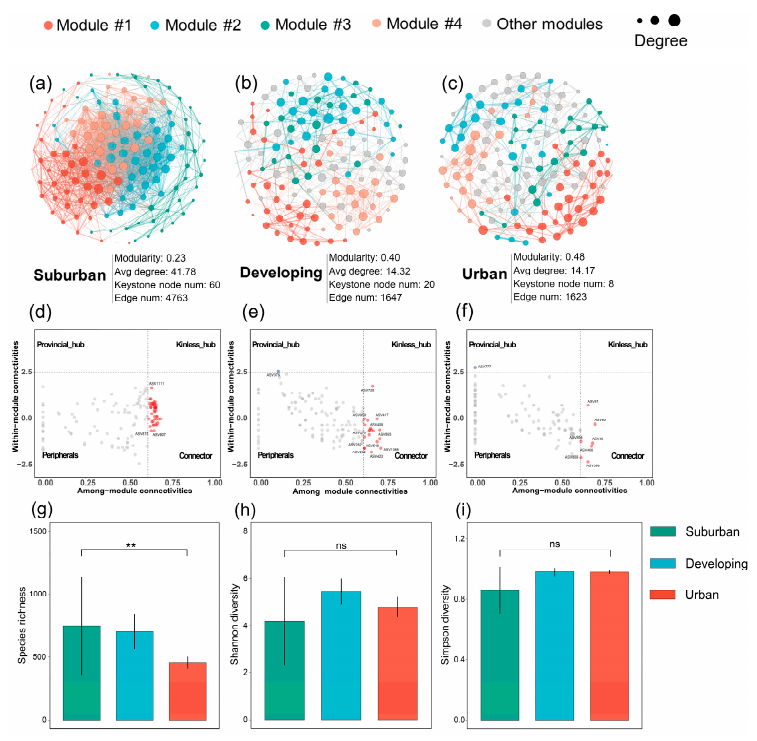
Figure 4. Co-occurrence networks ( a – c ), node network roles ( d – f ), and alpha diversity indexers ( g – i ) of phyllosphere microbiota of camphor trees along the urbanization gradient. Suburban, developing, and urban stand for the corresponding urbanization level for sampling. Avg degree—average degree; Keystone node num—keystone node numbers; Edge num—edge numbers. Threshold value for node network roles: kinless hubs ( z score > 2.5; c score > 0.62), provincial hubs ( z score > 2.5; c score ≤ 0.62), connectors ( z score ≤ 2.5; c score > 0.62), and peripherals ( z score ≤ 2.5; c score ≤ 0.62) were defined according to their within-module degree ( z score) and among-module degree ( c score). An asterisk denotes a significant statistical difference between treatments (**, p < 0.01), and ns indicates that the statistical difference is not significant. Table 1. The alpha diversity indexes of leaf phyllosphere microbiota of different urbanization levels.